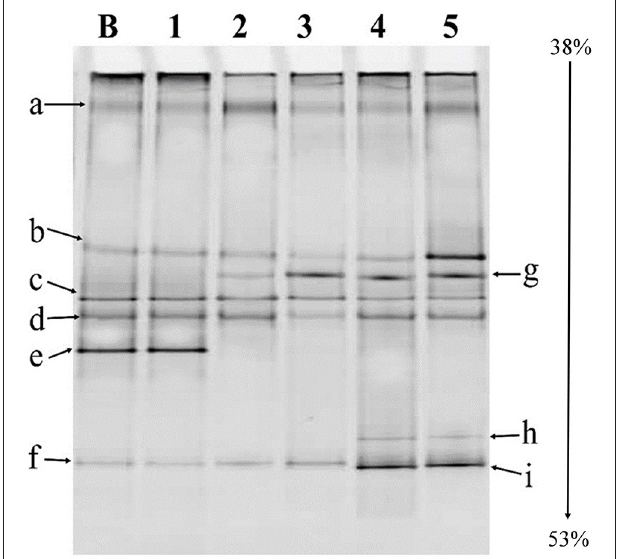
FIGURE 1 | PCR denaturing gradient gel electrophoresis (PCR-DGGE) fingerprinting of lactic acid bacteria (LAB). B, Bakhar; 1, first day